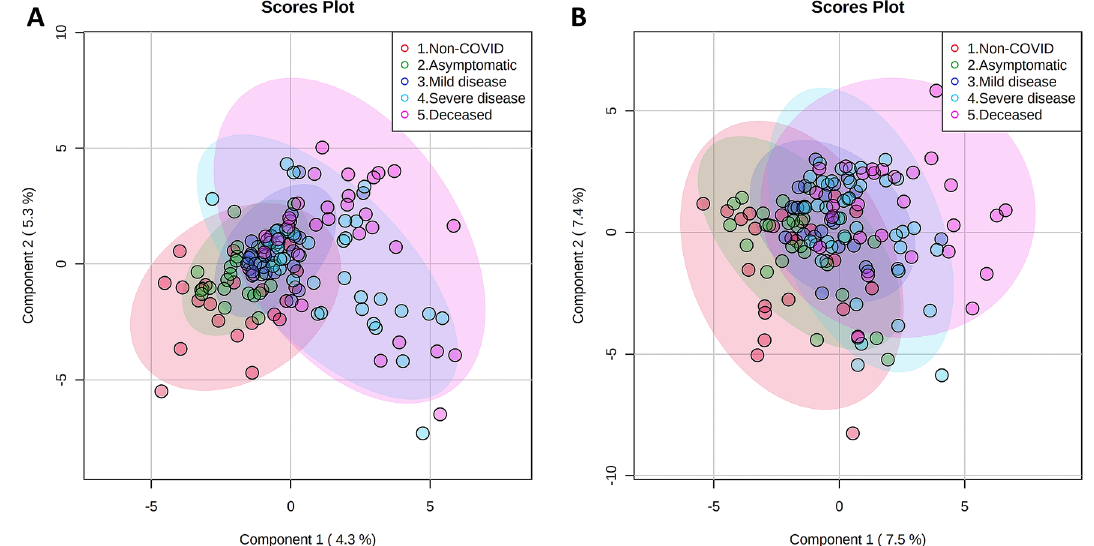
Figure 1. PLS-DA score plots of data obtained by RP/HPLC-qTOF MS/MS ESI (+) ( A ) and RP/HPLC-qTOF MS/MS ESI (–) ( B ) from plasma of patients collected at hospital